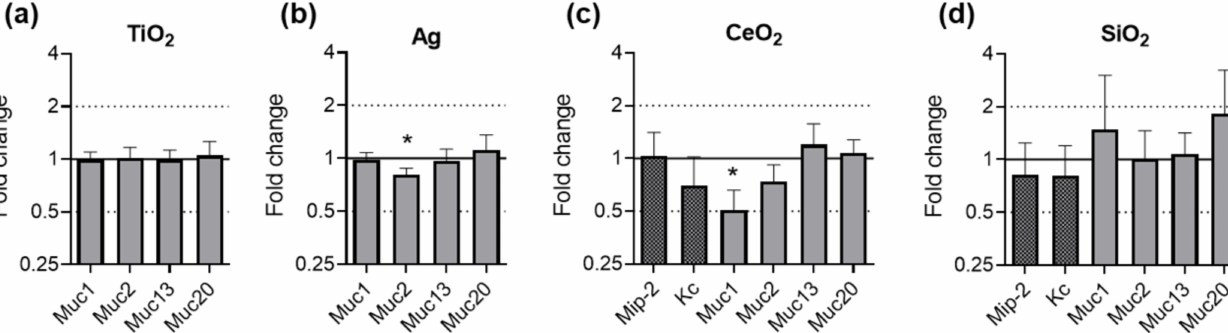
Figure 7. Gene expression of mucins in murine ileal tissues after ENM exposure. Female and male C57BL/6J mice were fed with feed pellets containing either no additive, 1.0% TiO 2 ( a ) or 0.2% Ag ( b ) for 28 days. Female C57BL/6J mice were fed with feed pellets containing either no additive, 1.0% CeO 2 ( c ) or 1.0% SiO 2 ( d ) for 21 days. The relative gene expression of Muc1, Muc2, Muc13 and Muc20 was assessed by qRT-PCR. The results for the ENM exposed mice were normalized to those in the control mice using Rplp0 as reference gene. The depicted fold changes with SEM were derived from the mean and SEM of the ∆∆ C T -values of N ≥ 5 independent experiments ( t -test; * p ≤